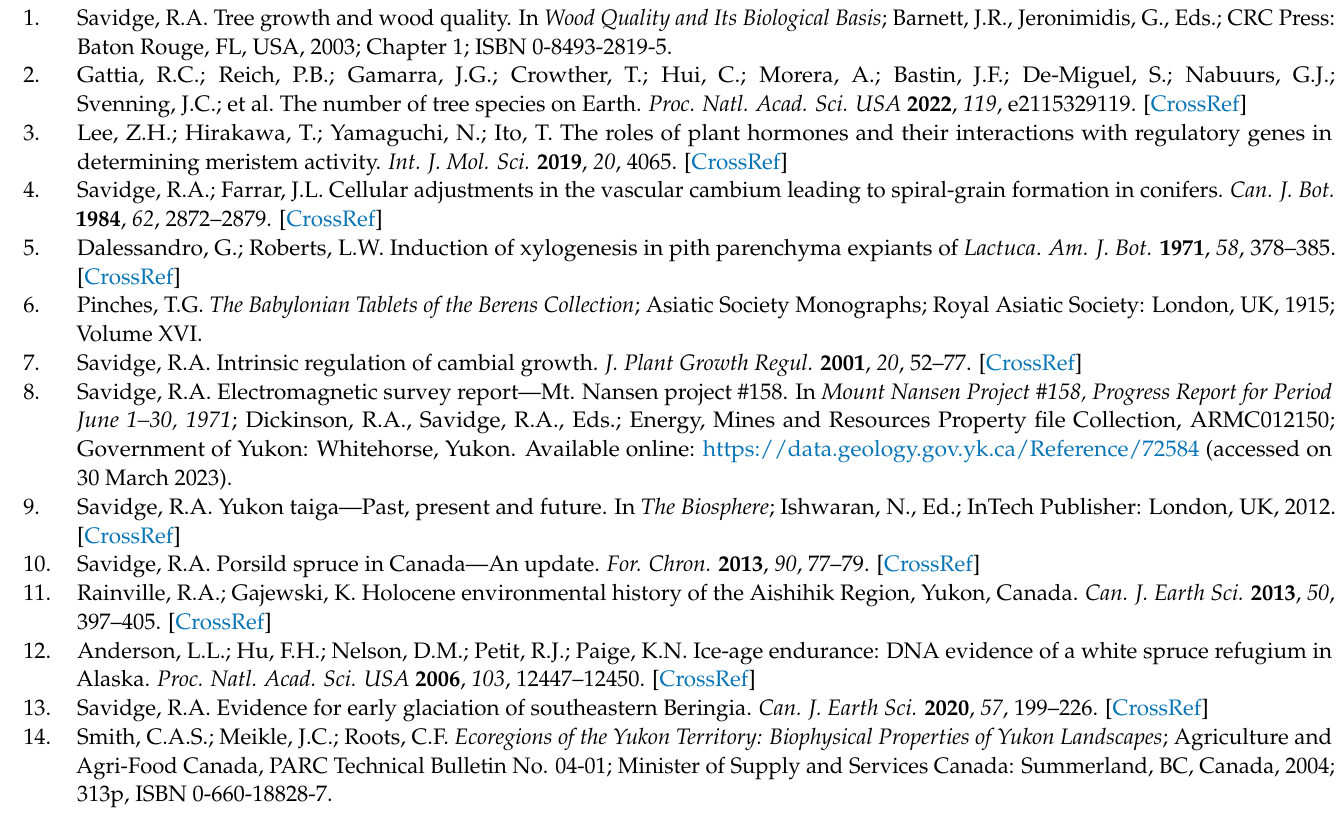
Table S2: Soil Moisture and pH Values; Ring-width (mm) spreadsheets: DATA1311, DATA1316, DATA1320, DATA1326, DATA1328,